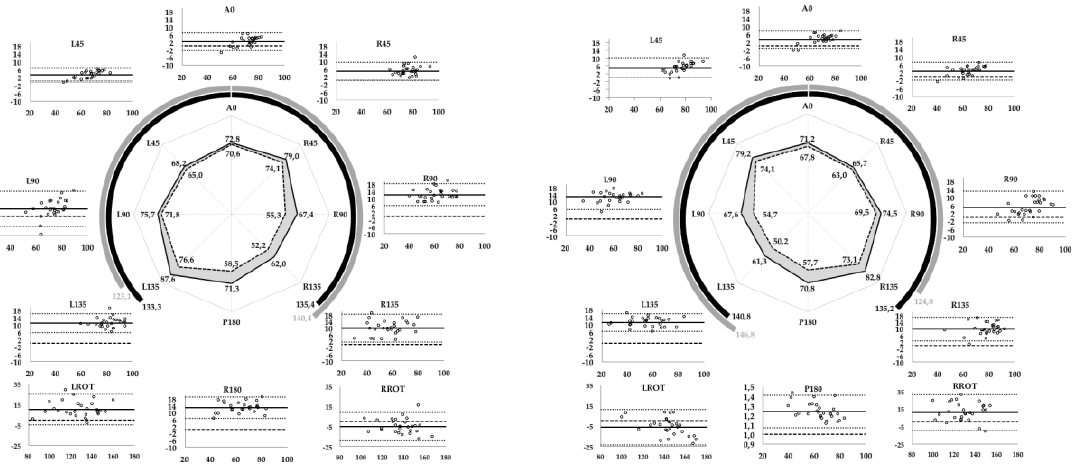
Figure 2. Agreement analysis of horizontal and rotational reaches left and right foot. Visual representation (center left and right) of horizontal reach test scores (full line Max m , dotted line Max kin and grey area showing difference). Circular graphs (Max kin grey, Max m black) of left and right rotational reaches. Bland Altman plots ( y -axis: Max diff (cm) and x -axis: Max mean (cm)) for all tests with fixed bias (full line) with 95% confidence interval (dotted line) and agreement (dashed line).